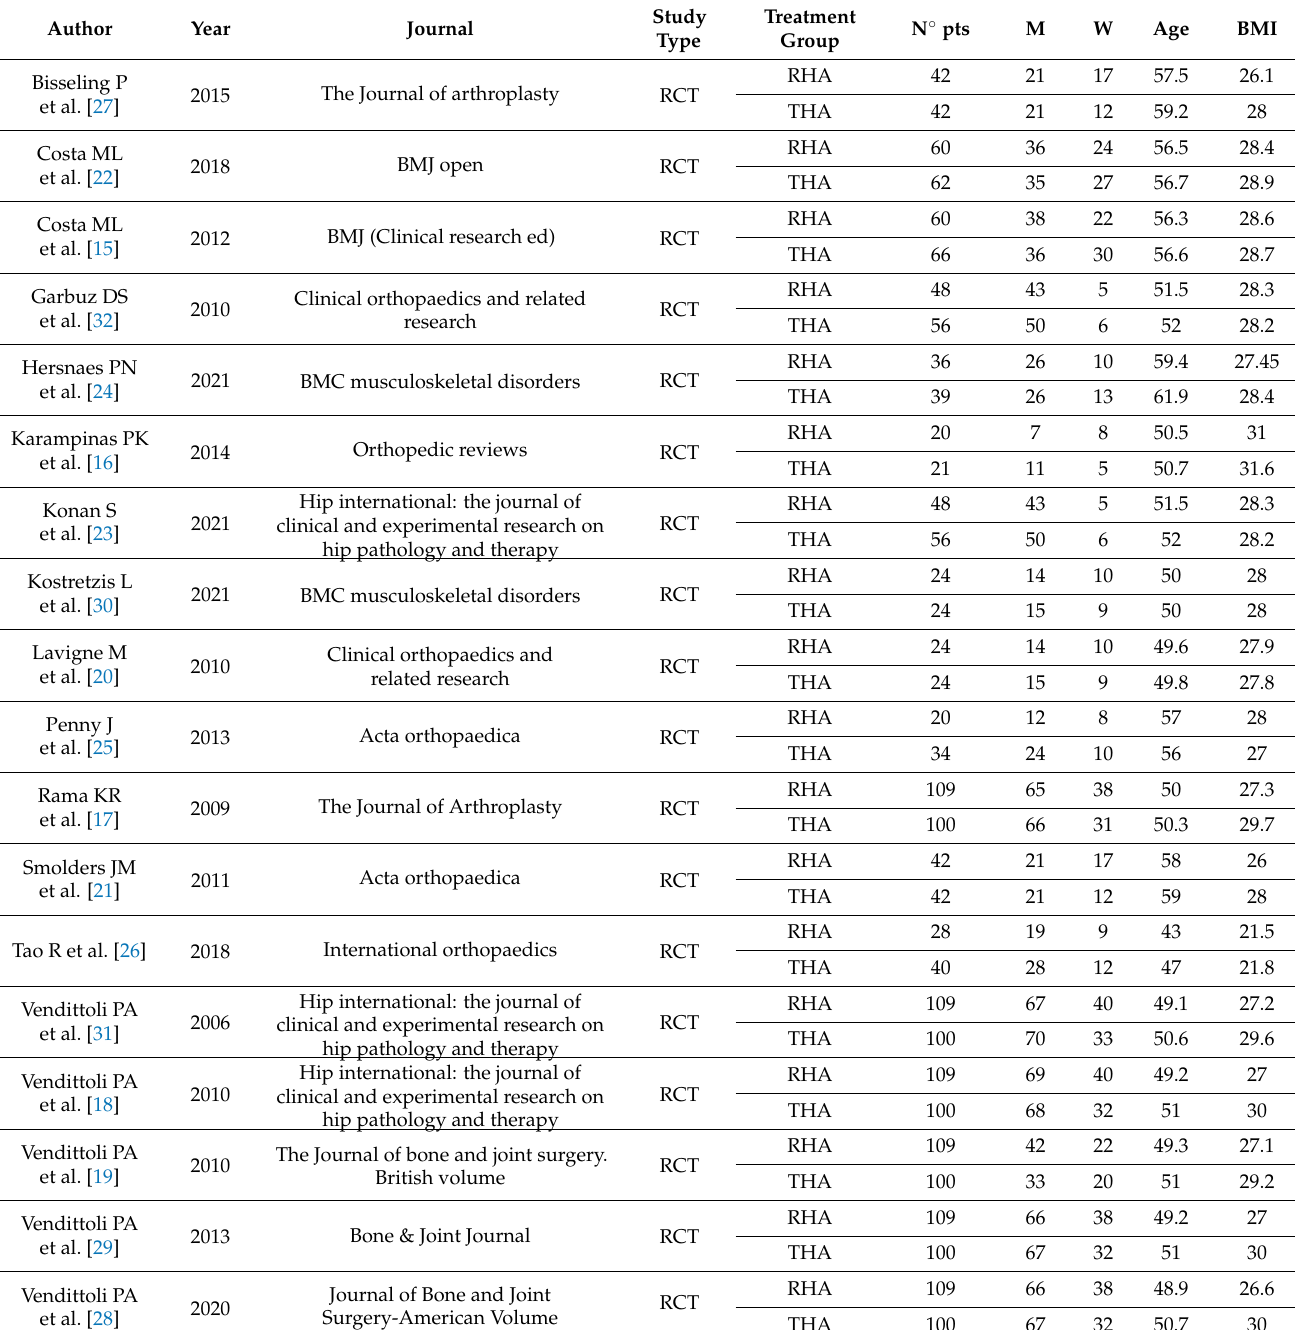
Table 1. Characteristics and technical aspects of eligible